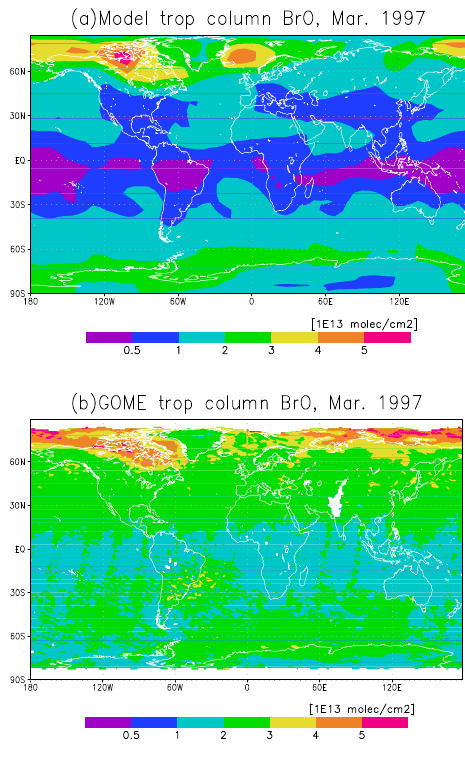
Fig. 2. Comparisons of BASE run (a) and retrieved (b) tropospheric column BrO in March of 1997.